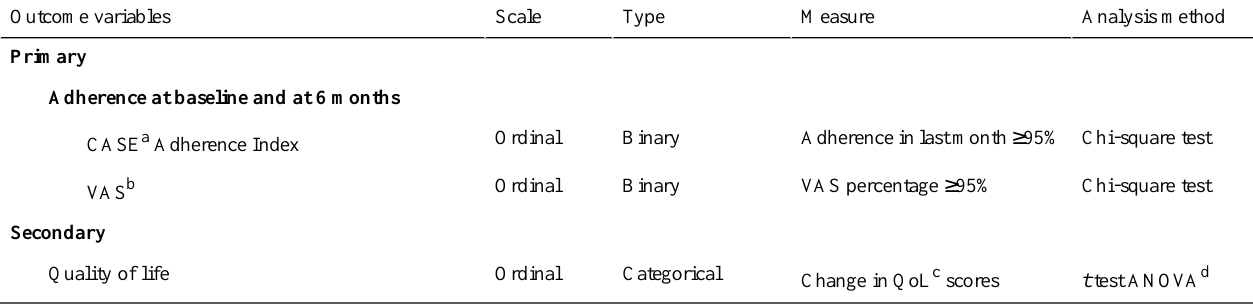
Table 1. Statistical tests to be used for different